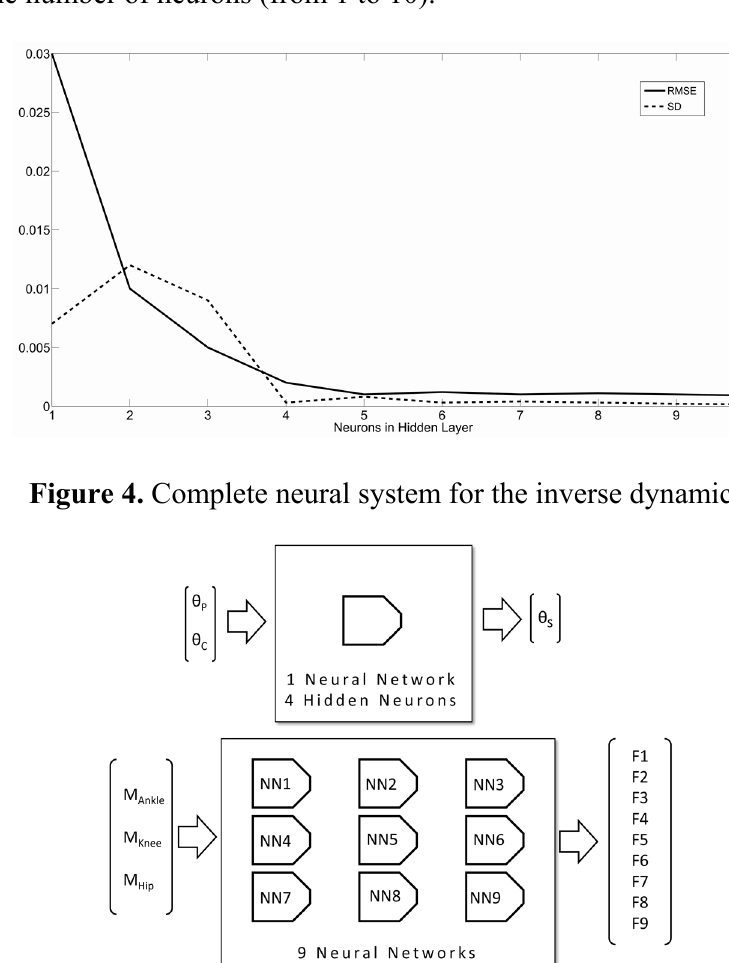
Figure 3. Root Mean Square Error (solid) and Standard Deviation (dashed) Error plot function of the number of neurons (from 1 to 10).